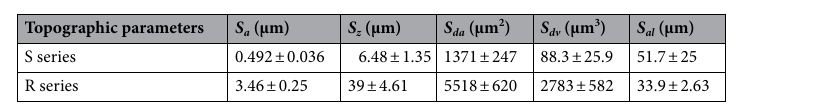
Table 1. Roughness parameters (mean ± standard deviation) obtained over the entire implant surface of samples from the S and R series.